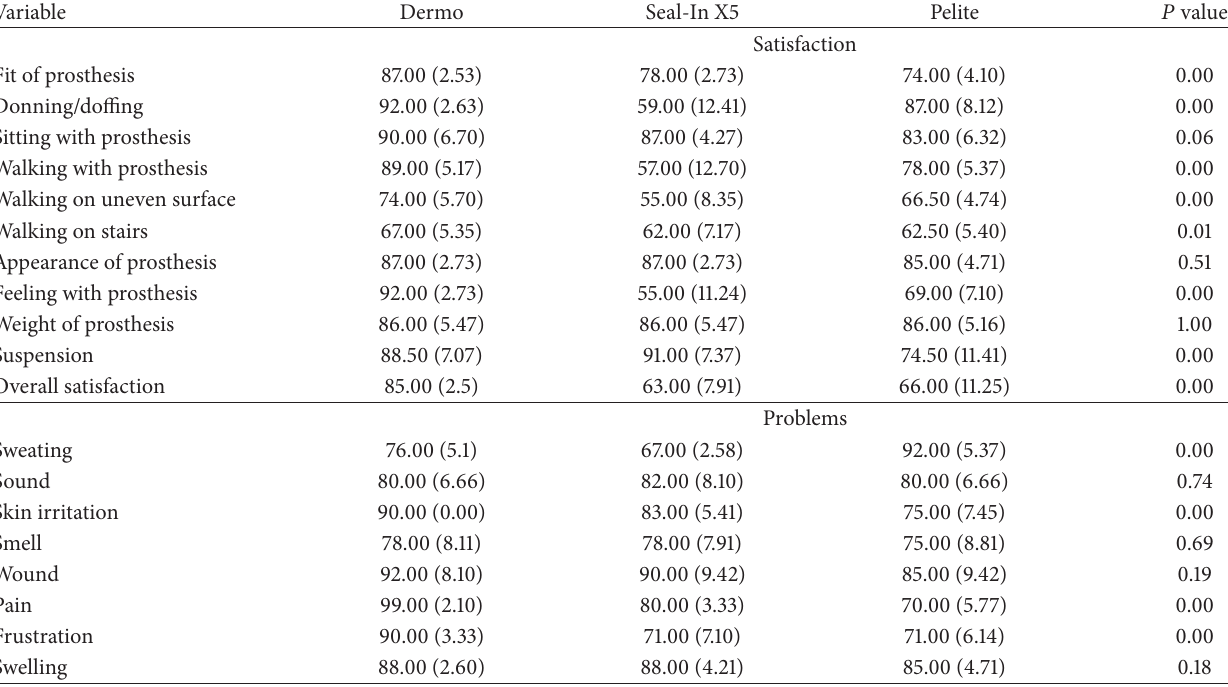
Table 2: Comparison between the three liners.